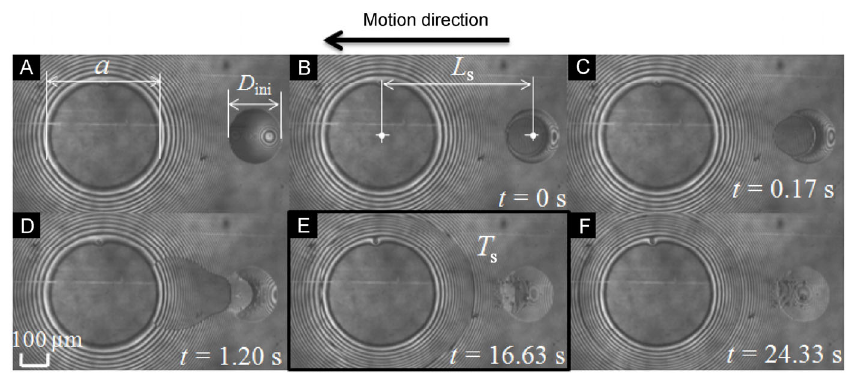
Fig. 3 Spreading process of a micro-oil droplet, PAO100, w = 54 N, D ini = 212 μ